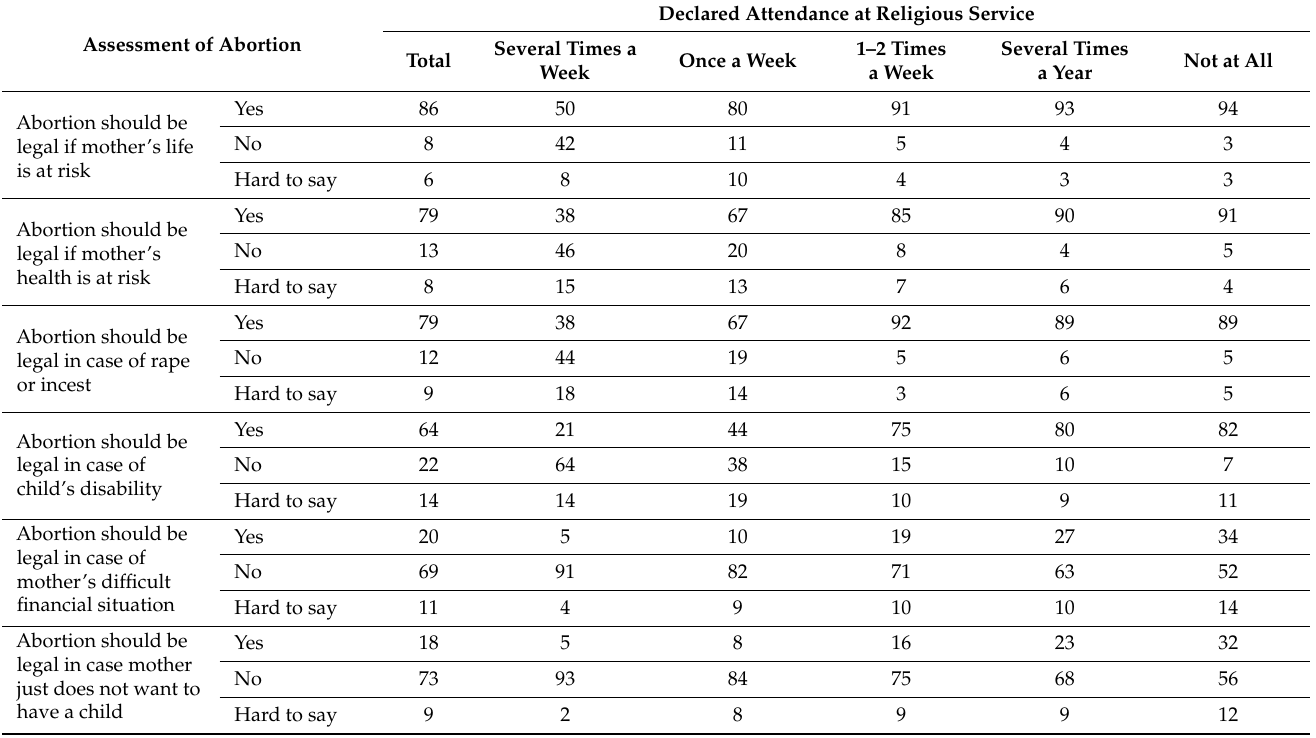
Table 3. Assessment of abortion according to declared religious practices in